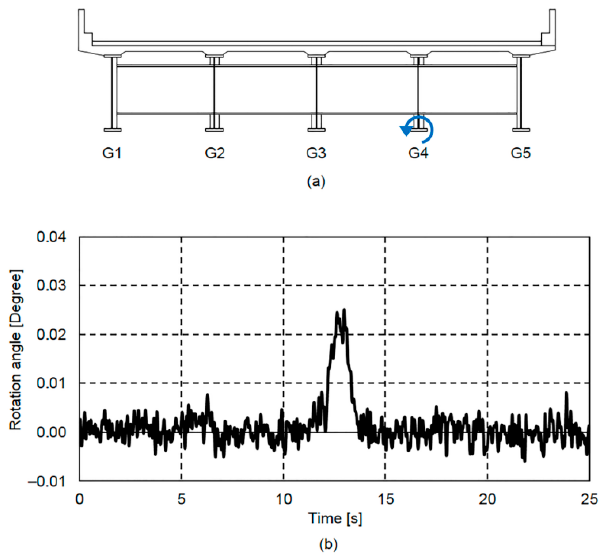
Figure 8. Normal direction of rotation angle response and rotation angle response obtained using two contact displacement gauges at G4: ( a ) normal direction of rotation angle response; and ( b ) rotation angle response.